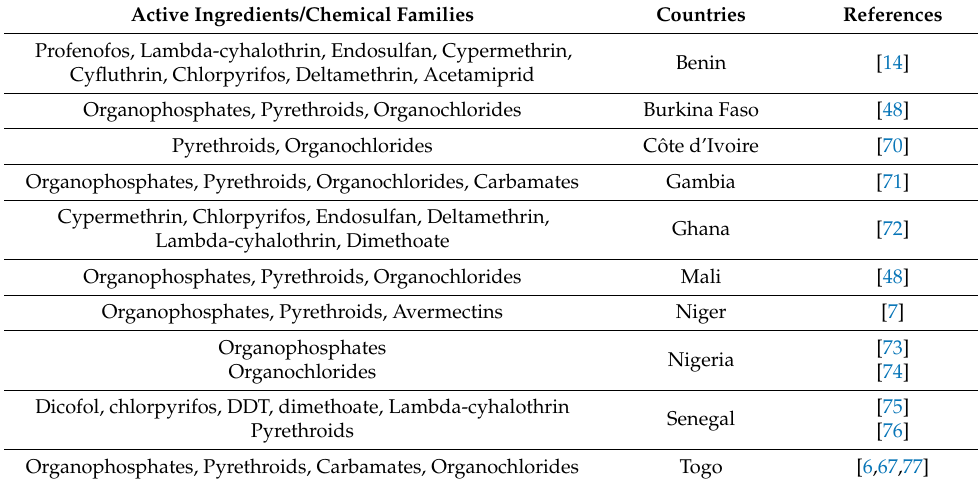
Table 2. Main active ingredients and insecticide families used by farmers growing cabbage in urban and peri-urban areas in West